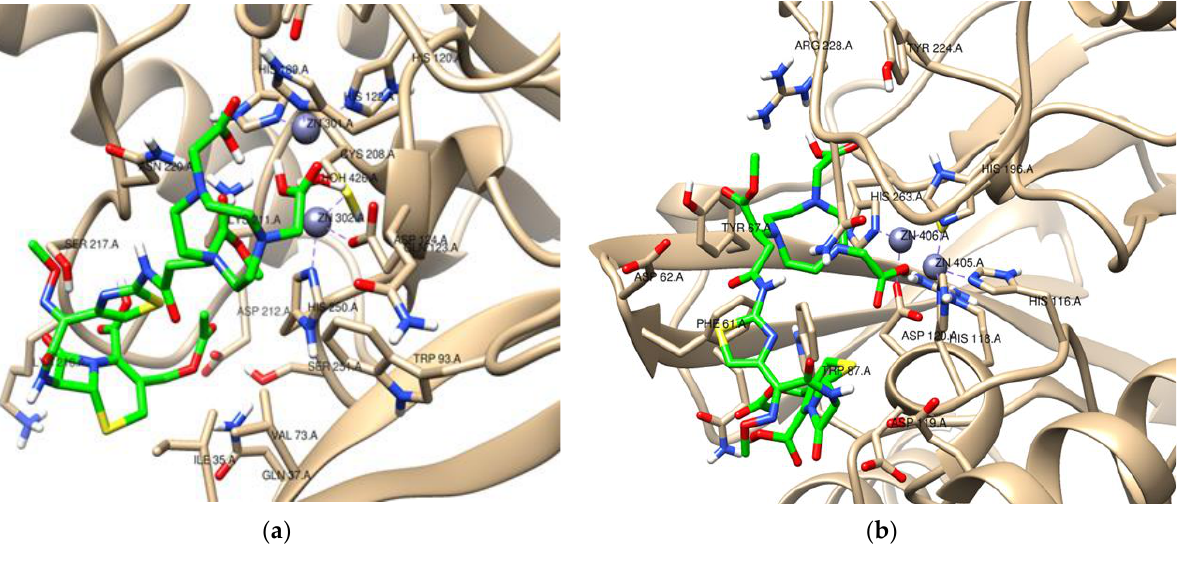
Figure 5. Docked 3D structures of the BP2_SR with NDM-1 and VIM-2 enzyme (shown in green). ( a ) NDM-1-BP2 complex shows the coordination between the chelator carboxylic moieties with Zn 2+ (301). Zn 2+ (301) is coordinated to three histidines, and a water molecule (HOH426) that coordinates the two Zn 2+ ions. Zn 2+ (302) coordinate histidine, aspartate, and cysteine. ( b ) VIM-2– BP2 complex shows the coordination between the chelator carboxylic oxygen with Zn 2+ (406). In VIM-2, the Zn 2+ (405) coordinates three histidines, while Zn 2+ (406) coordinates histidine, aspartate, and cysteine residues. The chelator carboxylic moieties coordinate Zn 2+ (405). The diagrams rendered show the BP2_SS configuration. The 3D structures of all the complexes are available with the supplementary